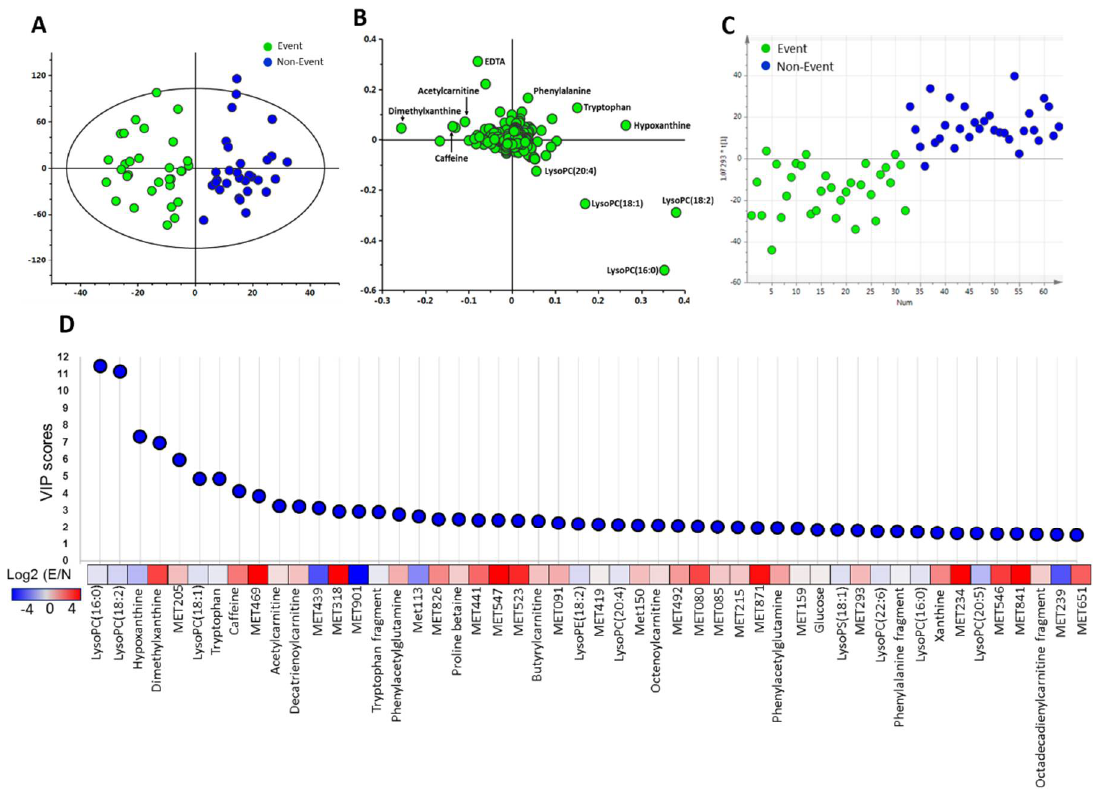
Figure 1. Changes in metabolome of heart failure patients. The OPLS-DA score plot ( A ) show considerable separation between 30 non-event patients (blue) and 31 heart failure (HF) event patients (green). The ellipse shown in the model represents the Hotelling T2 with 95% confidence. Each point represents one patient, and the cohort to which they belong is color-coded as shown in the legend box. The loading plot ( B ) of metabolite profiles, each point in represents one metabolite. ( C ) Score plots of orthogonal projection to latent structure discriminant analysis (OPLS-DA) prediction model is used to determine the success of the models for classifying the event and non-event groups. All of the sample were applied to construct the model, and the Y axis-predicted scatter plots assigned samples to either event or non-event group using a priori cut-off at 0. ( D ) The top 50 metabolites were ranked according to variable importance in the projection (VIP) score of OPLS-DA model. The heat map shows the ratio of abundance (log2) between event and non-event group. The un-identified metabolites are showed with metabolite ID.